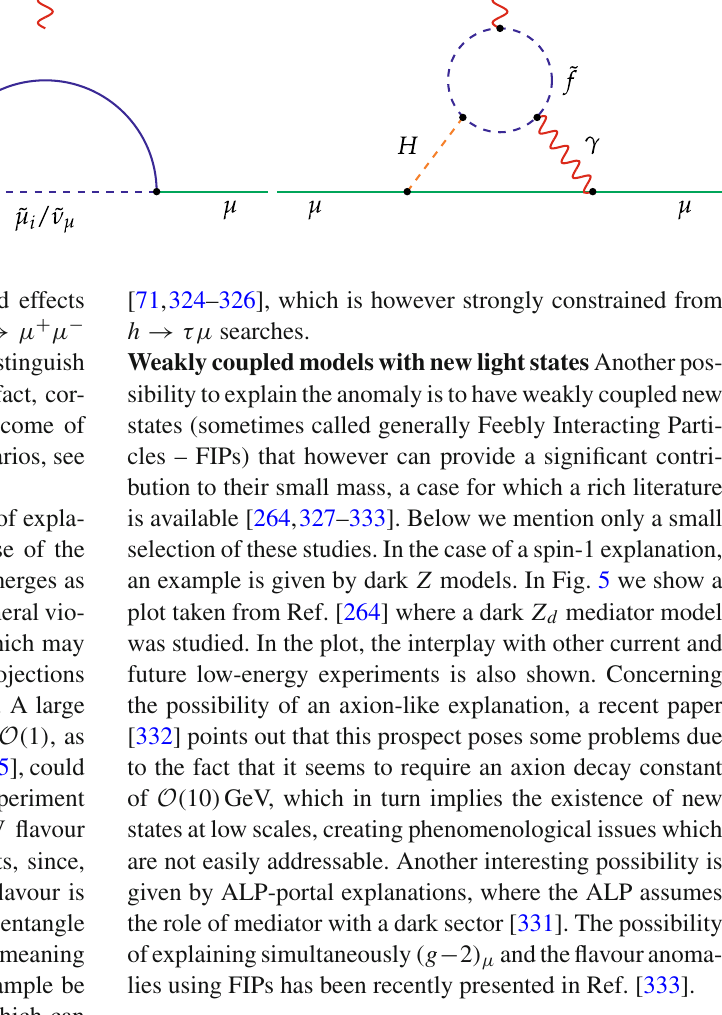
Fig. 4 Left: One-loop contributions to ( g − 2 ) μ from MSSM particles; the external photon line can be attached to any charged particle. Right: Example of a two loop Barr-Zee contribution involving a charged sfermion